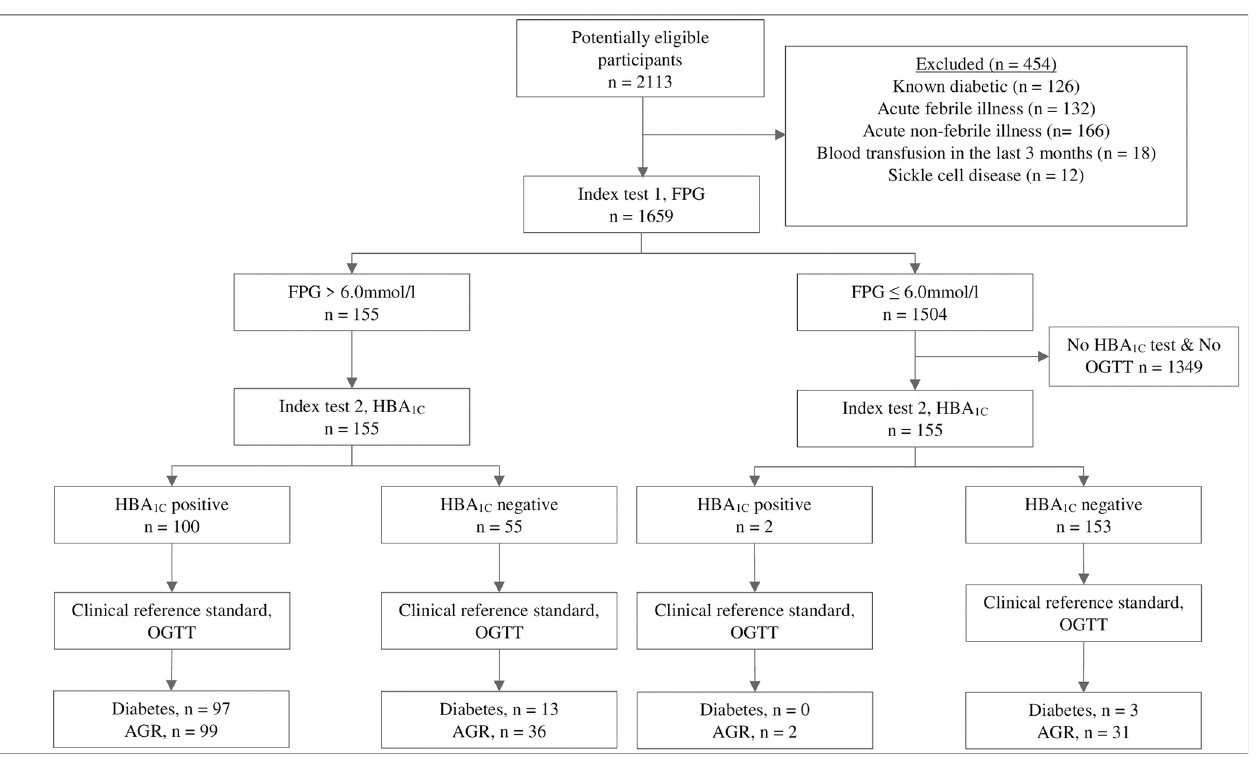
Fig 1. Flow of participants through the